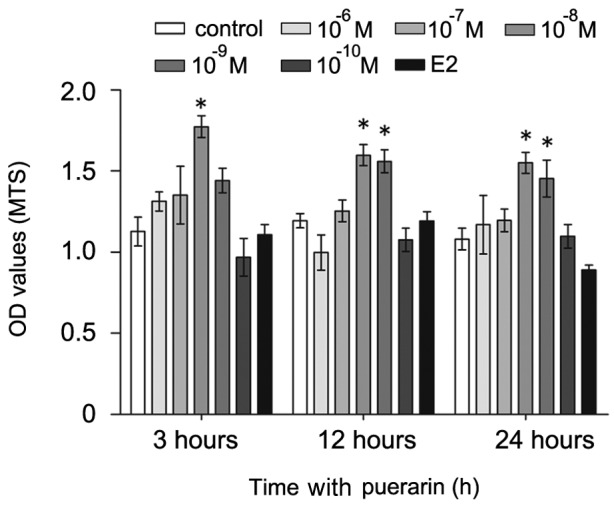
Puerarin promotes hFOB1.19 cell proliferation. Cells proliferation was measured using an MTS detection kit. The cells were treated with 0 M and 10−6–10−10 M puerarin for 3, 12 and 24 h. Treatment with 10−8 and 10−9 M puerarin significantly increased cell proliferation. Data are presented as the mean ± standard deviation. *P<0.05, vs control. OD, optical density.